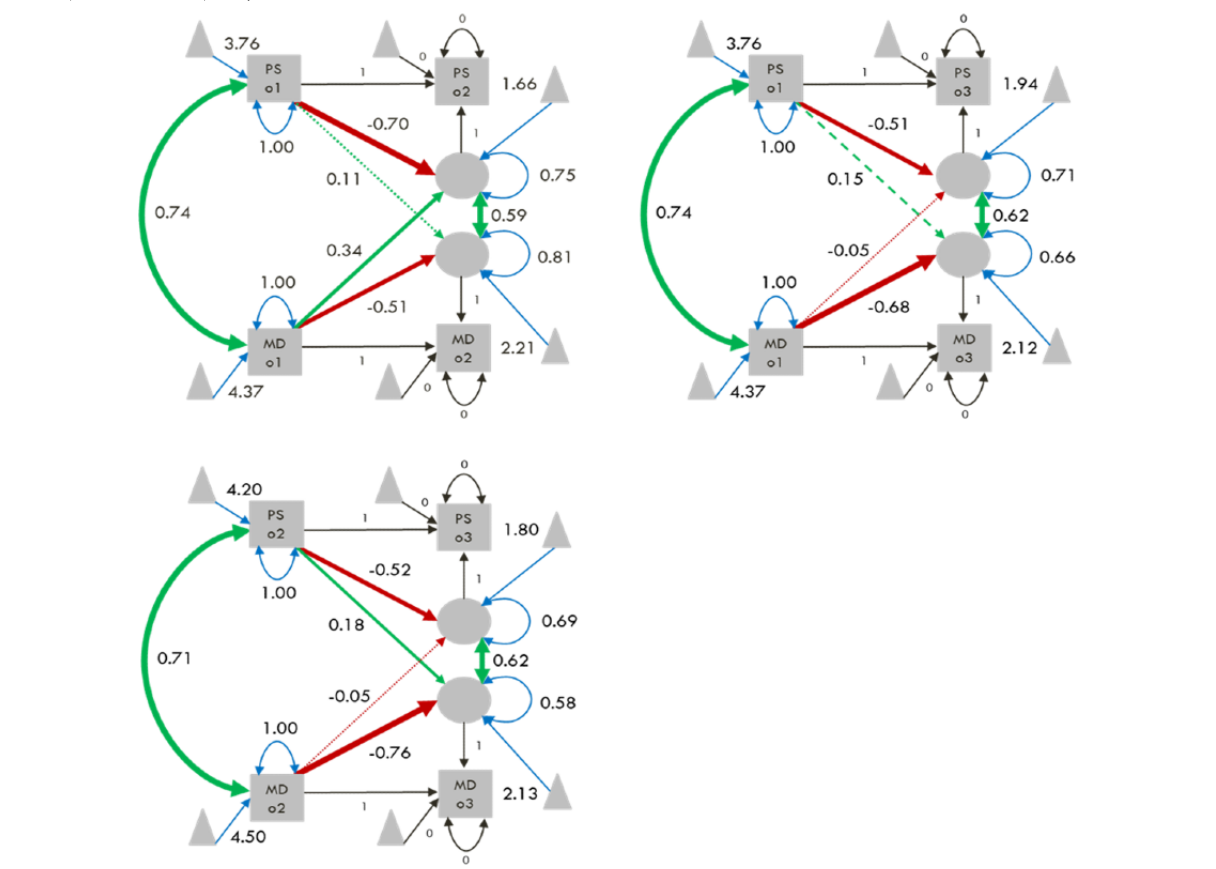
Figure 3. Bivariate Latent Change Score Models. The upper-left panel depicts occasions 1-2, the upper-right panel depicts occasions 1-3, and the lower-left panel depicts occasions 2-3. Green arrows represent positive associations, red arrows represent negative associations, black arrows represent fixed parameters, and blue arrows represent estimated intercepts and variances. Double-headed arrows represent covariances and variances, and single-headed arrows represent intercepts, regressions, and autoregressions. Solid lines indicate a significant association ( P <.05), dashed lines indicate marginal association (.05 ≥ P <.10), and dotted lines indicate nonsignificant association ( P ≥ .10). Gray squares represent manifest variables, gray circles represent latent variables, and gray triangles represent intercepts. All depicted estimates are standardized. MD: mental distress; o1: occasion 1; o2: occasion 2; o3: occasion 3; PS: perceived